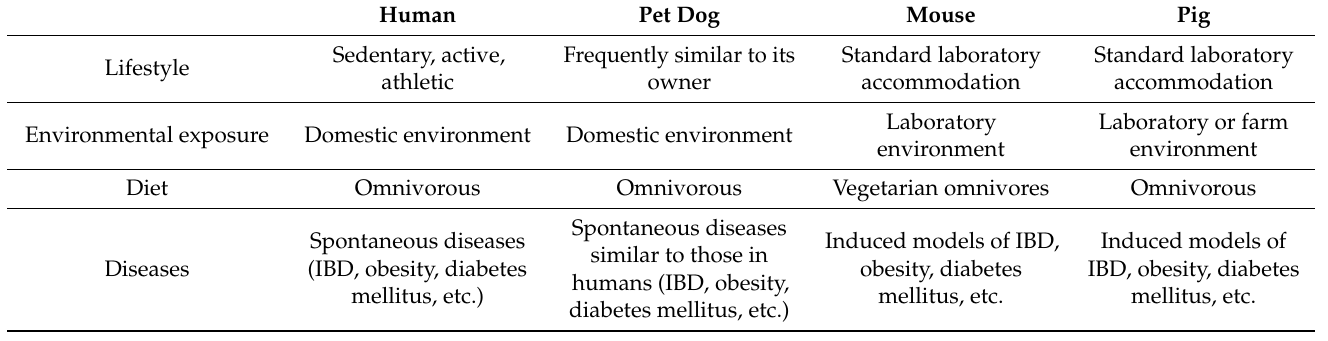
Table 1. Comparative physiology of humans, dogs, mice and pigs. Pet Dog Mouse Pig